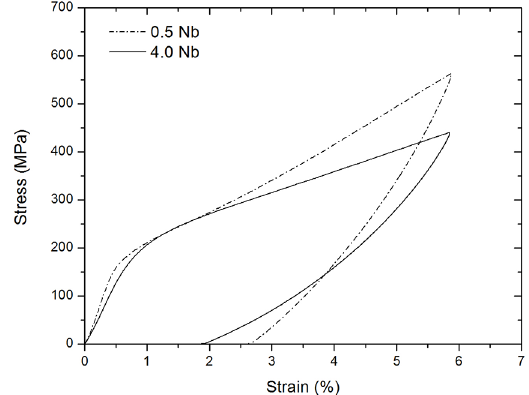
Figure 3. Test for the quantification of superelasticity at the temperature of Ms + 30 °C for Cu-11.8Al-0.6Be-0.5Nb (wt.%) and Cu-11.8Al-0.6Be-4Nb (wt.%)